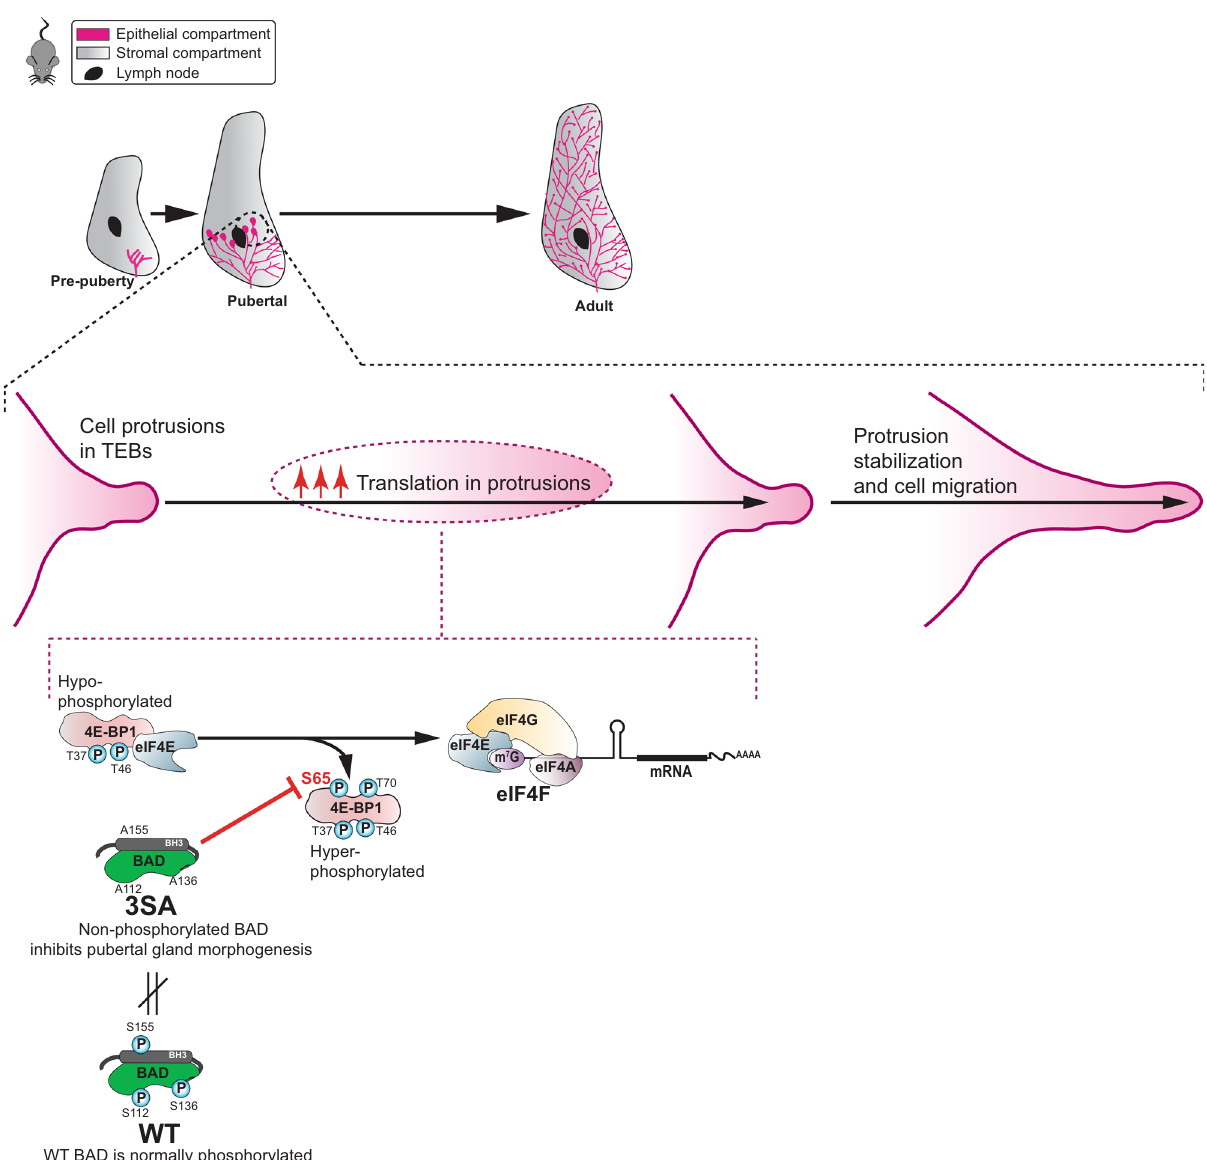
Fig. 8 Schematic model for the role of BAD in normal pubertal mammary development. BAD is normally phosphorylated in the pubertal mammary gland and this is permissive for 4E-BP1 hyperphosphorylation and subsequent upregulation of localized translation for ef fi cient cell migration and epithelial tree elongation. Preventing BAD phosphorylation (3SA) inhibits hyperphosphorylation of 4E-BP1 that impairs cell migration and tree a New Objective PicoChip reverse-phase analytical LC column, with spray voltage set to 2700 V. Mass spectrometry data processing . Raw data fi les comprising an entire gel lane were grouped and searched using Proteome Discoverer (PD) 1.4.1.14 ’ s SEQUEST search engine using a reviewed, non-redundant complete Mus musculus proteome retrieved from UniprotKB on October 16, 2015 102 . Magellan storage fi les from all n = 15 samples were opened in unison using the PD 1.4.1.14 software package, with data fi ltered to show only proteins identi fi ed with at least 2 medium con- fi dence peptides (FDR <0.05 per peptide). Relative protein abundance was deter- mined using proteins ’ extracted ion chromatograms (EICs) using PD 1.4.1.14 ’ s ‘ Precursor Ion Areas ’ module, in relation to the summation of all EICs from a given sample. Data were exported to Microsoft Excel. Hierarchical clustering and random forest classi fi cation . Both MS and RPPA protein pro fi le unsupervised hierarchical clustering was performed on MATLAB (clustergram function). Samples distance metric was set to correlation, and average distance between all pairs of objects in any two clusters was used to create